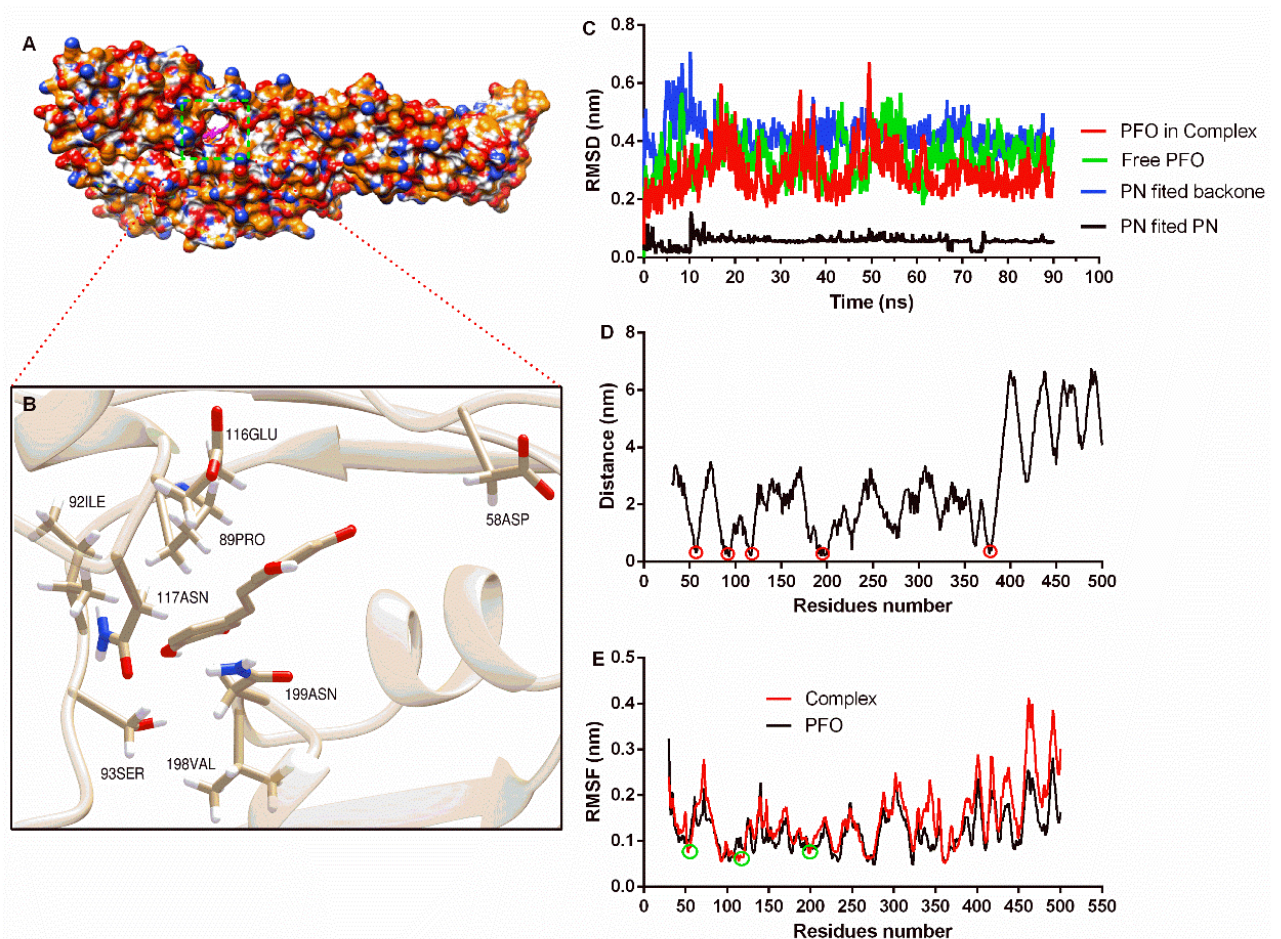
Figure 2. The binding mode of piceatannol and PFO and the stability of proteins, ligands and residues during binding. ( A ) The binding mode of piceatannol and PFO. ( B ) The interaction between residues and piceatannol. ( C ) The RMSD values during the molecular dynamics simulation. ( D ) The distance between residues and piceatannol. The residues in the circle show closer distance to piceatannol. ( E ) The flexibility of residues when bound with or without piceatannol. The RMSF of residues in the circle are reduced after bound with piceatannol.